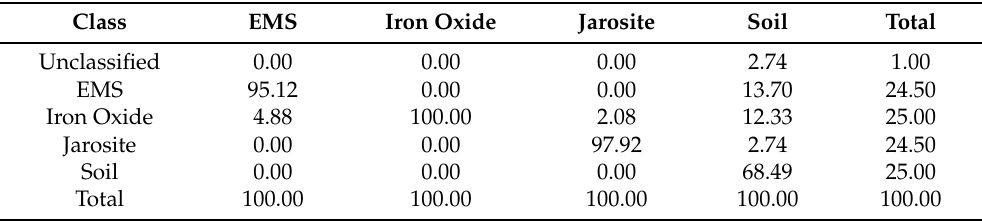
Table A3. June 2018 maximum likelihood. Overall accuracy points: 174/200, overall accuracy: 87%, kappa coefficient: 0.8272.